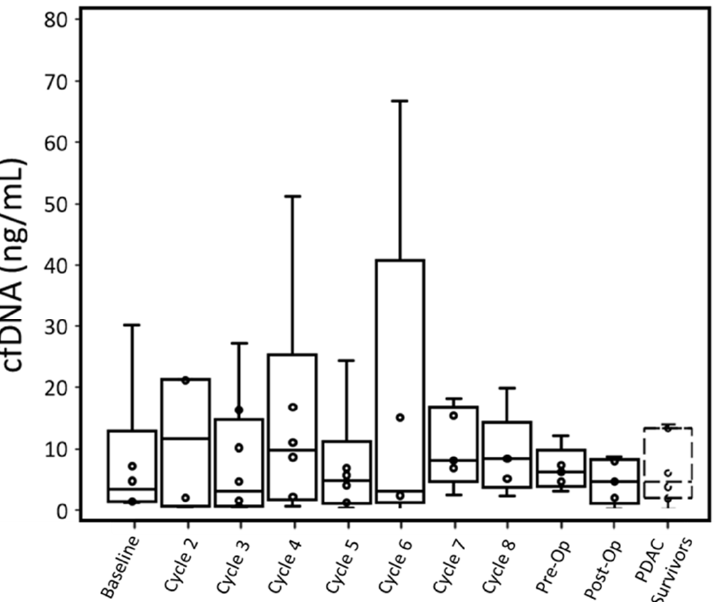
Figure 2. Trend of cfDNA concentration of all patients measured by qPCR over the treatment cycles, pre-operation (pre-OP) and post-operation (post-OP). PDAC survivor samples are included for comparison. The whiskers represent the minimum and maximum; the box bottom, the bar inside the box, and the box top represent lower quartile, median, and upper quartile; the cross represents the average; and each circle represents one data point.